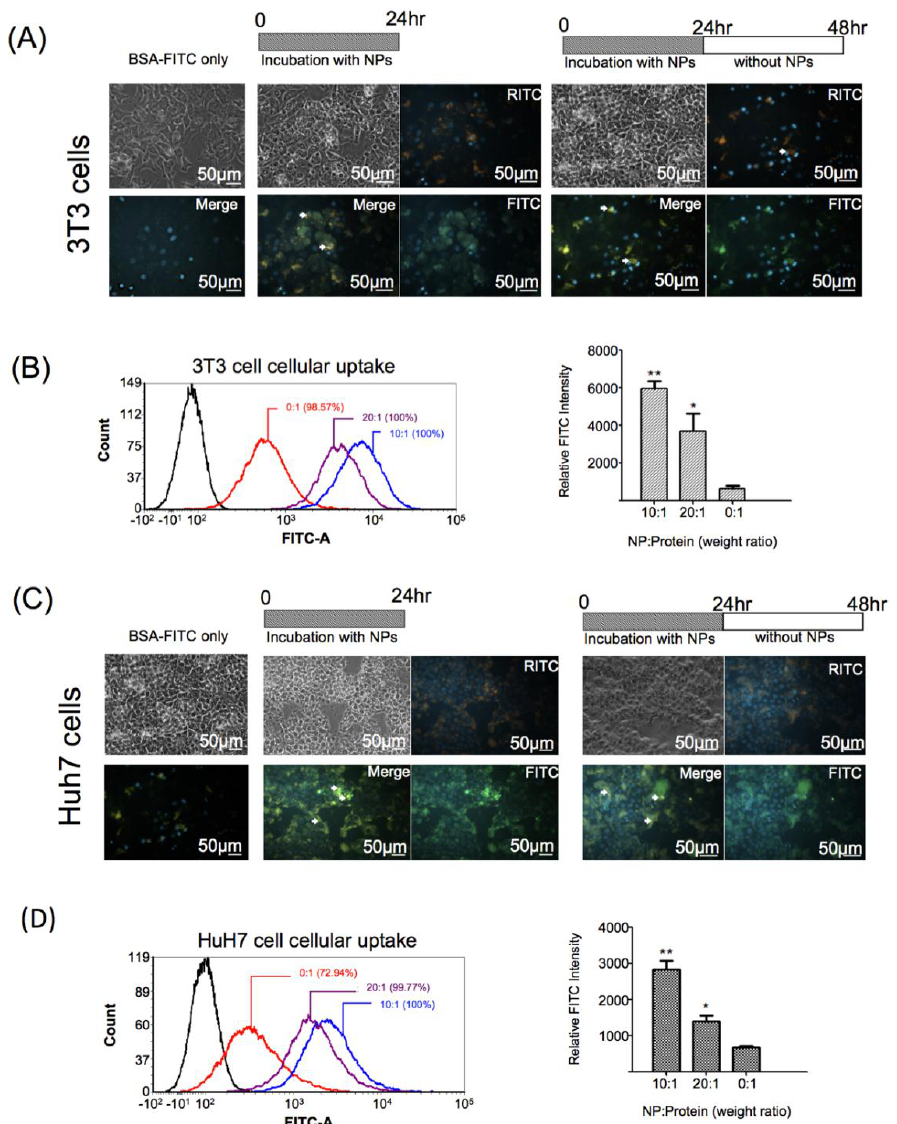
Figure 5. Intracellular protein delivery by GR-PEI NPs. Fluorescent images of protein delivery by GR-PEI NPs in 3T3 fibroblast ( A ) and Huh7 cells ( C ) for 24 h and 24 h after treatment (Bar: 50 µ m). The cells were incubated with BSA-FITC carried by GR-PEI NPs and free BSA-FITC (final protein concentration was 5 µ g/mL). Different formulations of BSA-FITC loaded GR-PEI NPs and free BSA-FITC (final protein concentration was 2 µ g/mL) were added to 3T3 fibroblast cells and Huh7 cells for 24 h. The protein delivery efficiency was evaluated by flow cytometry and quantified by measuring the geometric mean of FITC fluorescent intensity ( B , D ). The representative results are shown as M ± SD ( n = 3). Each bar represents the means of three determinations ± SD. * p < 0.05, ** p < 0.01 among the indicated groups.